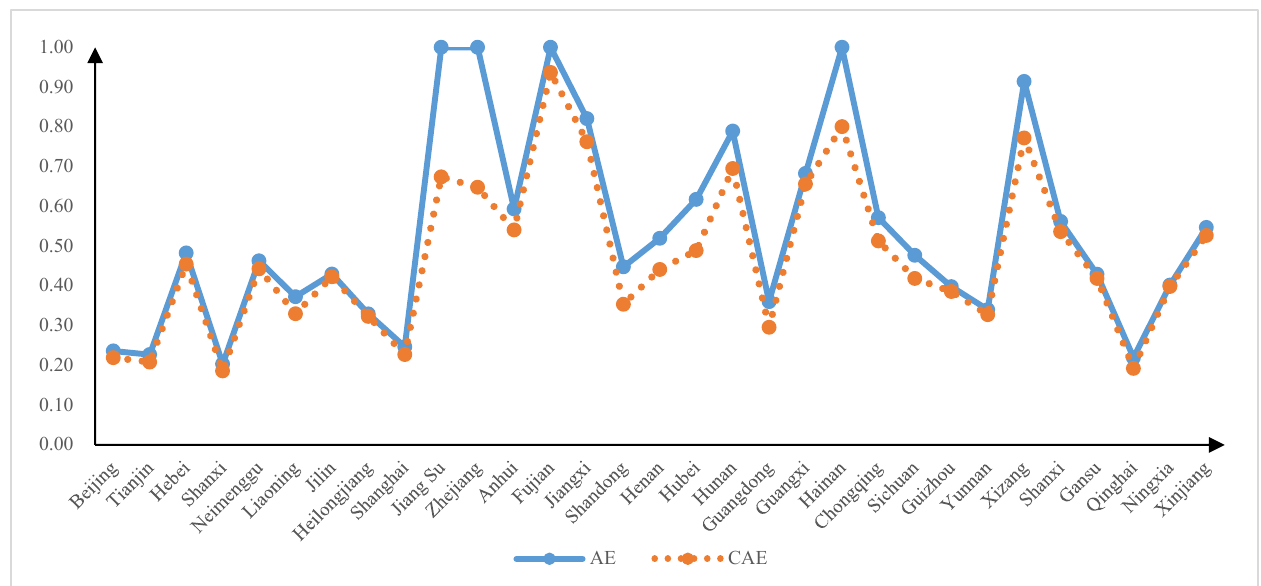
Figure 2. Comparative analysis of average production efficiency in 2010–2020.